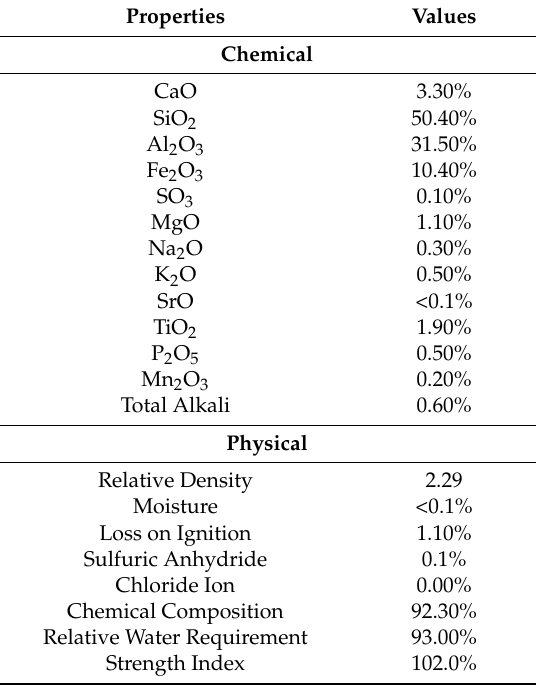
Table 1. Properties of fly